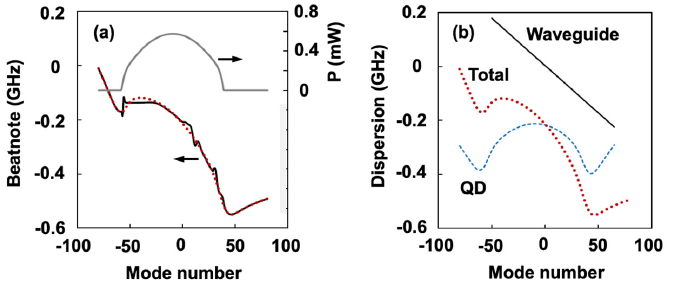
Figure 7. ( a ) Effects of mode locking on beat-notes. The solid black curve is the beat-notes spread over the lasing spectrum (thin black curve). The red dotted curve is the variation in beat-note in the absence of mode locking. The solid gray curve is the mode intensities. ( b ) The red dotted curve is the total variation in beat-notes (same as in a ). The contributions to it are from the GaAs waveguide (solid black curve) and InAs QD carrier-induced refractive index change (blue dashed curve).